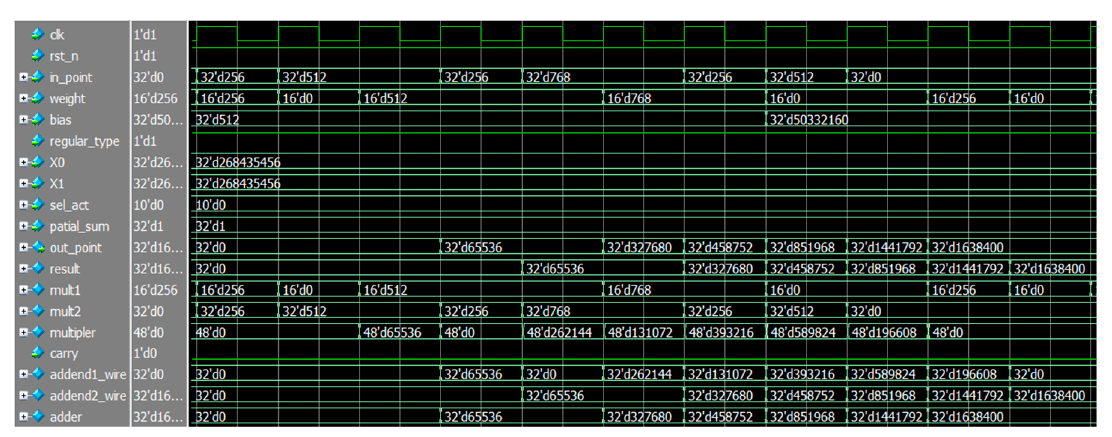
Figure 10. The signal simulation results of PE. Table 2. The overall resource utilization of the design.